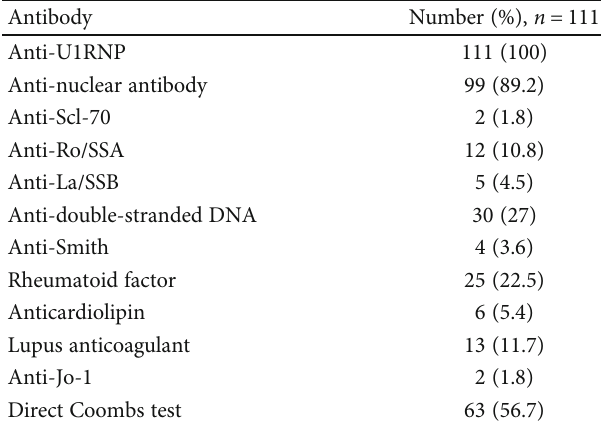
Table 2: Clinical features of mixed connective tissue disease. Table 3: Antibody pro fi le of mixed connective tissue